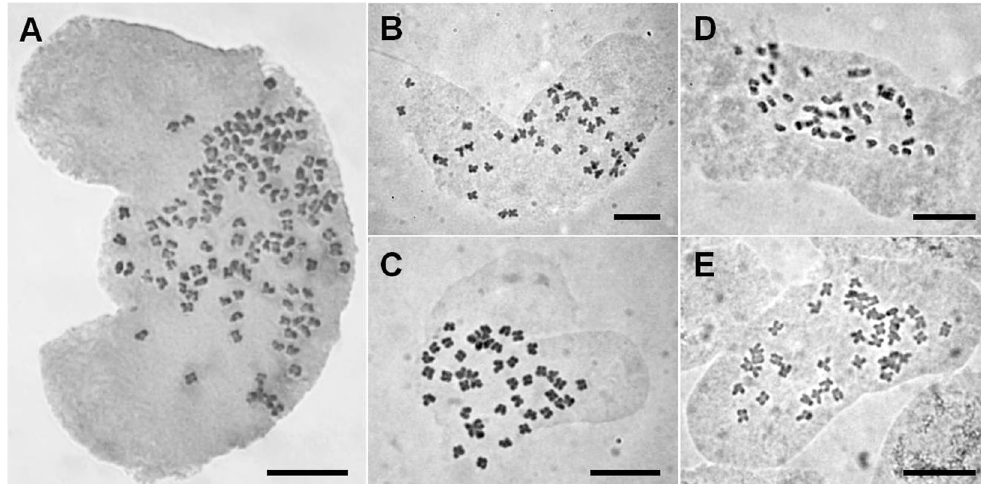
Figure 2. Mitotic chromosomes of representative individuals of F. sachalinensis and F. japonica var. japonica . Population and accession numbers correspond to those in Fig. 1 and Supplementary Table 1. ( A ) F. sachalinensis (2n = 132; population 4, S_ul05) ( B ). F. sachalinensis (2n = 44; population 23, S_sk05) ( C ). F. sachalinensis (2n = 44; population 34, S_hk05) ( D ). F. sachalinensis (2n = 44; population 54, S_hn16) ( E ). F. japonica var.